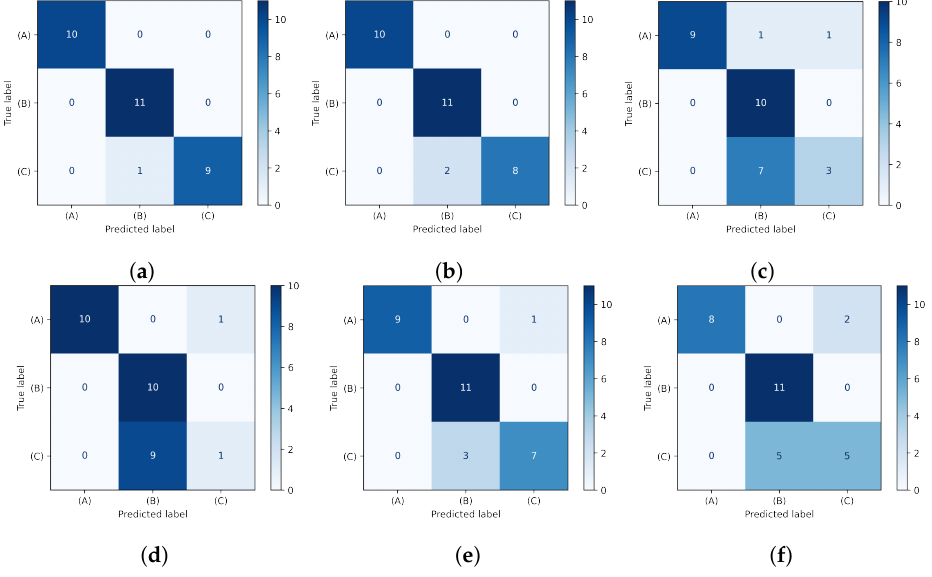
Figure 12. Confusion matrices for different training and validation subsets made from the same datasets of three chosen classes: ( A ) one tooth broken; ( B ) five teeth broken; ( C ) two teeth broken. Figures ( a – f ) present classification results for the subsets used in Figure 11. The following matrices show results for various subsets obtained by use of different seed numbers in the dataset splitting method. Matrices ( a , b , e ) show situations, where errors are negligible. ( d ) presents the worst obstained example of a badly chosen seed number, which led to ineffective classifier training due to the small size of the dataset. Those issues to lesser scale were visible for ( c , f ). Most of errors were related to similarity between different numbers of teeth